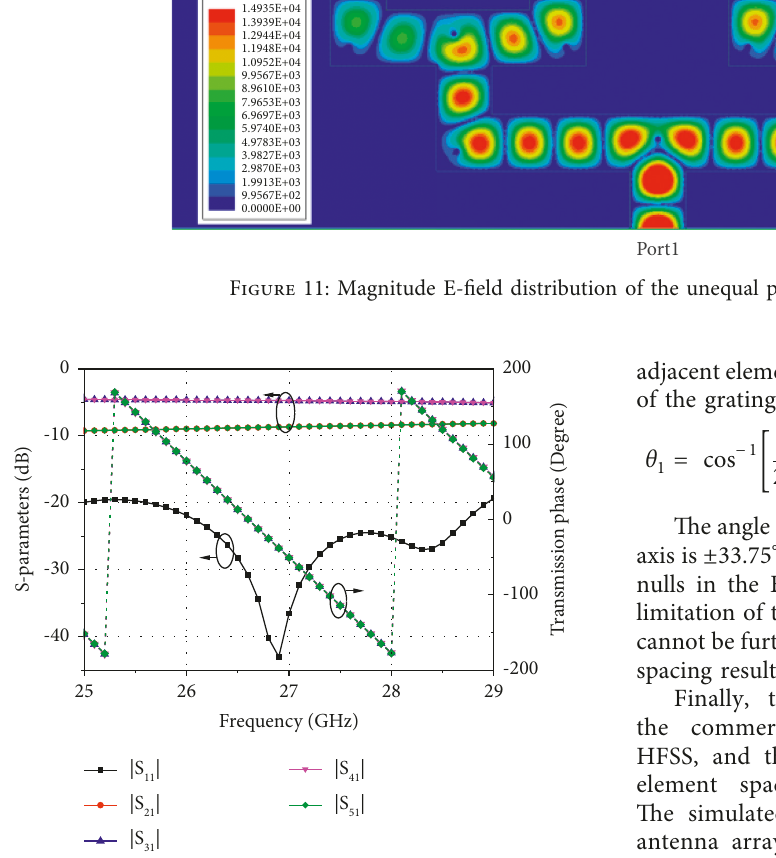
Figure 12: Simulated S-parameters of the unequal power